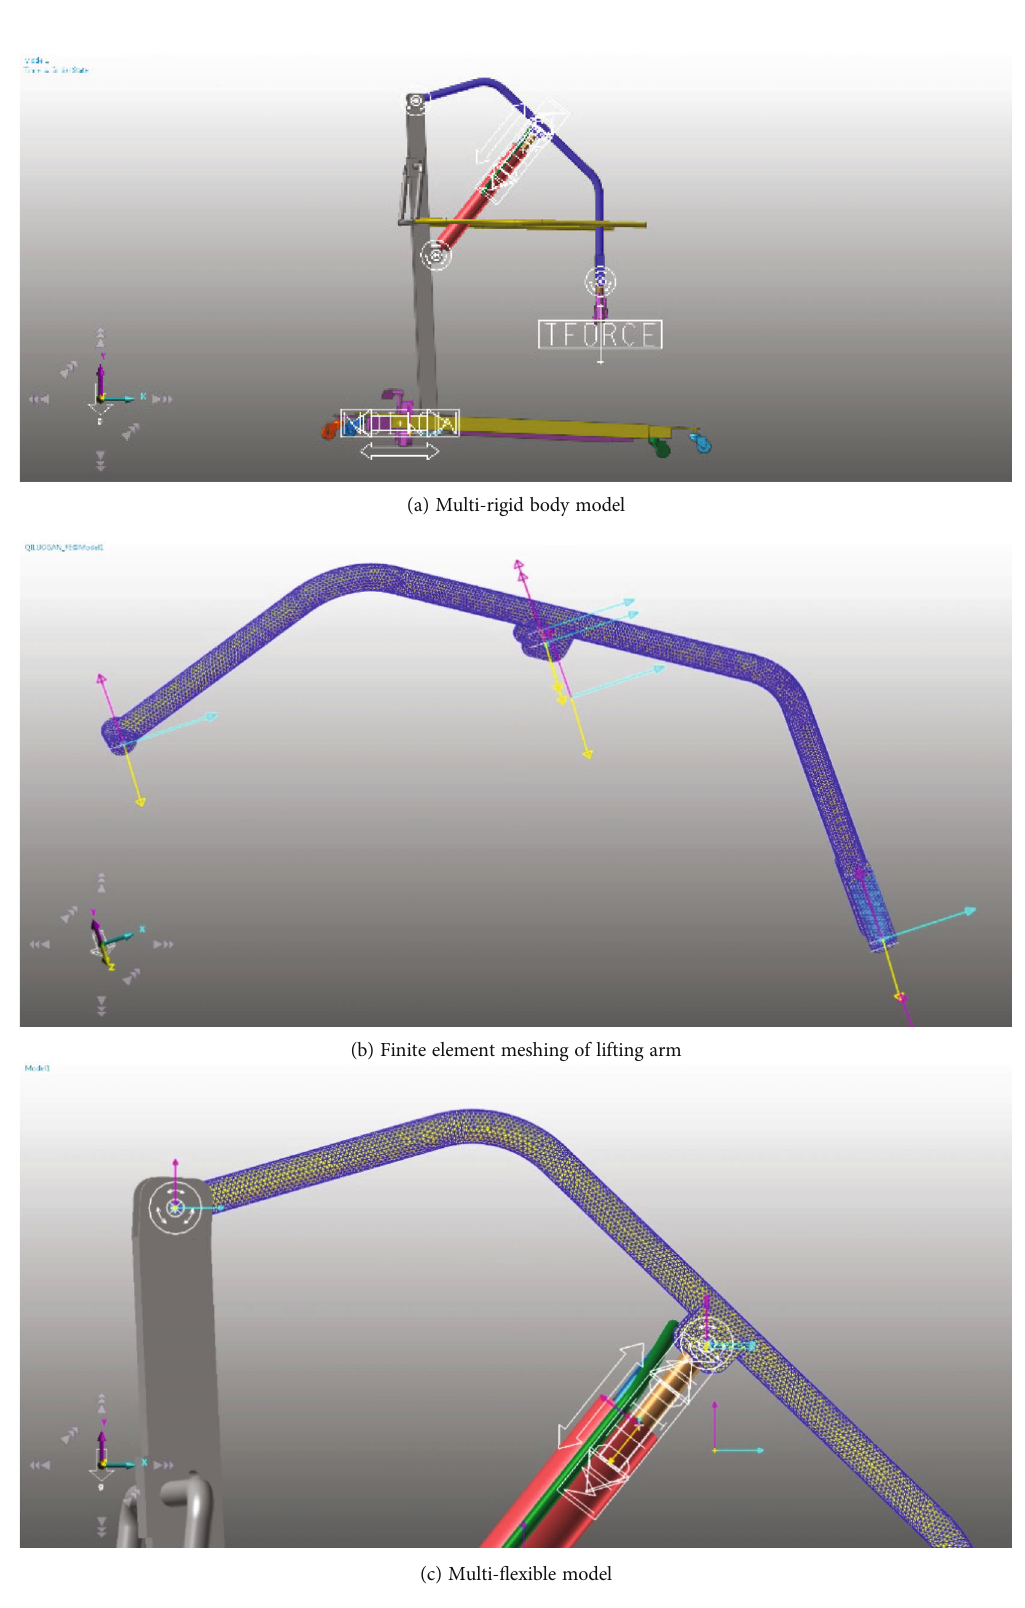
Figure 3: The patient transfer device multi-rigid body model is as shown in Figure3(a); the fi nite element meshing of lifting arm is as shown in Figure3(b); and the multi- fl exible model is as shown in